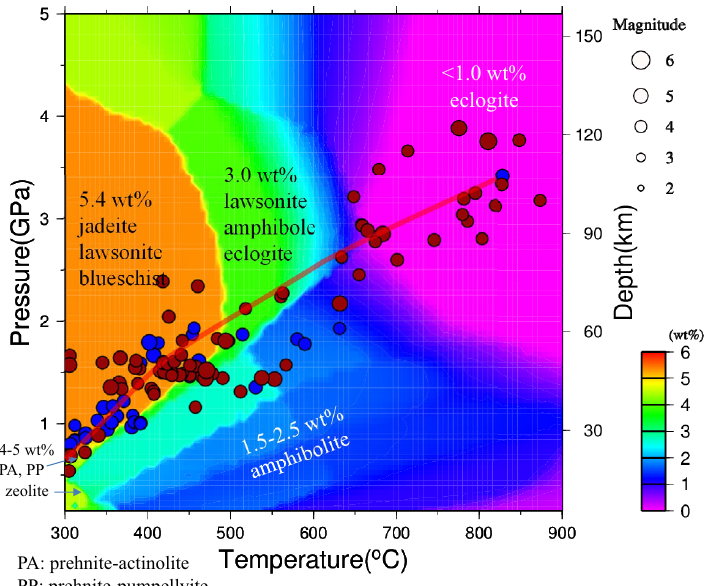
Figure 5. P–T conditions for M > 4 earthquakes near the plate interface plotted on the phase diagram for the metamorphic rocks of subducted oceanic crust (MORB layer) beneath the northern Marianas (blue, < 17°N) and southern Marianas (dark red, > 17°N). Colored circles indicate the interplate earthquakes and intraslab earthquakes, which occurred from Jan. 1, 2000, to Dec. 31, 2009 (IRIS). The figure was created by using